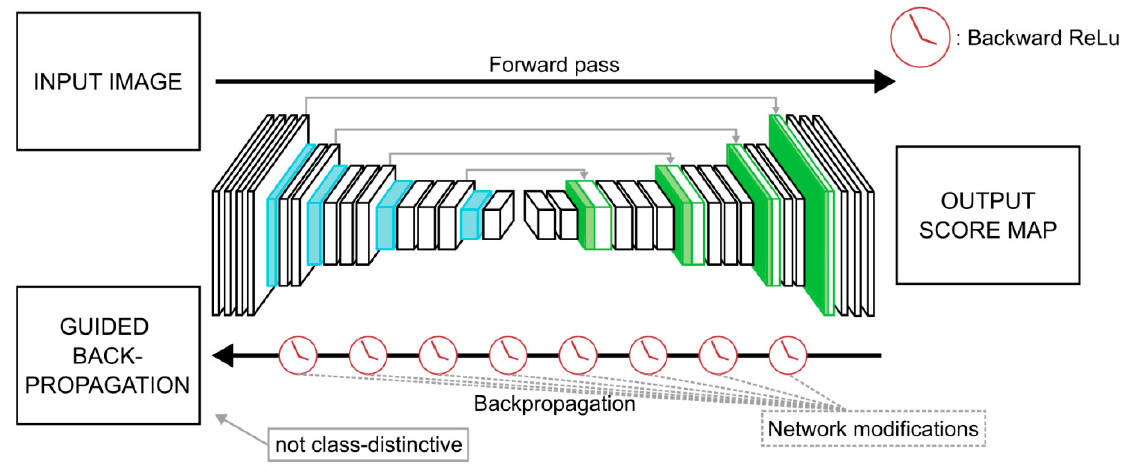
Figure 2. Applying guided back-propagation to a semantic segmentation network.